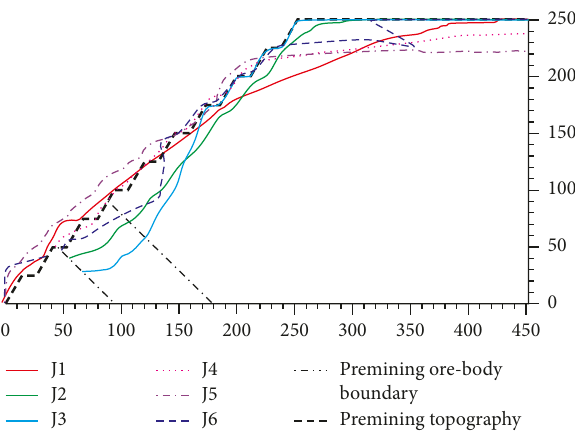
Figure 10: Profiles of the collapsed slopes for the J1 ∼ J6